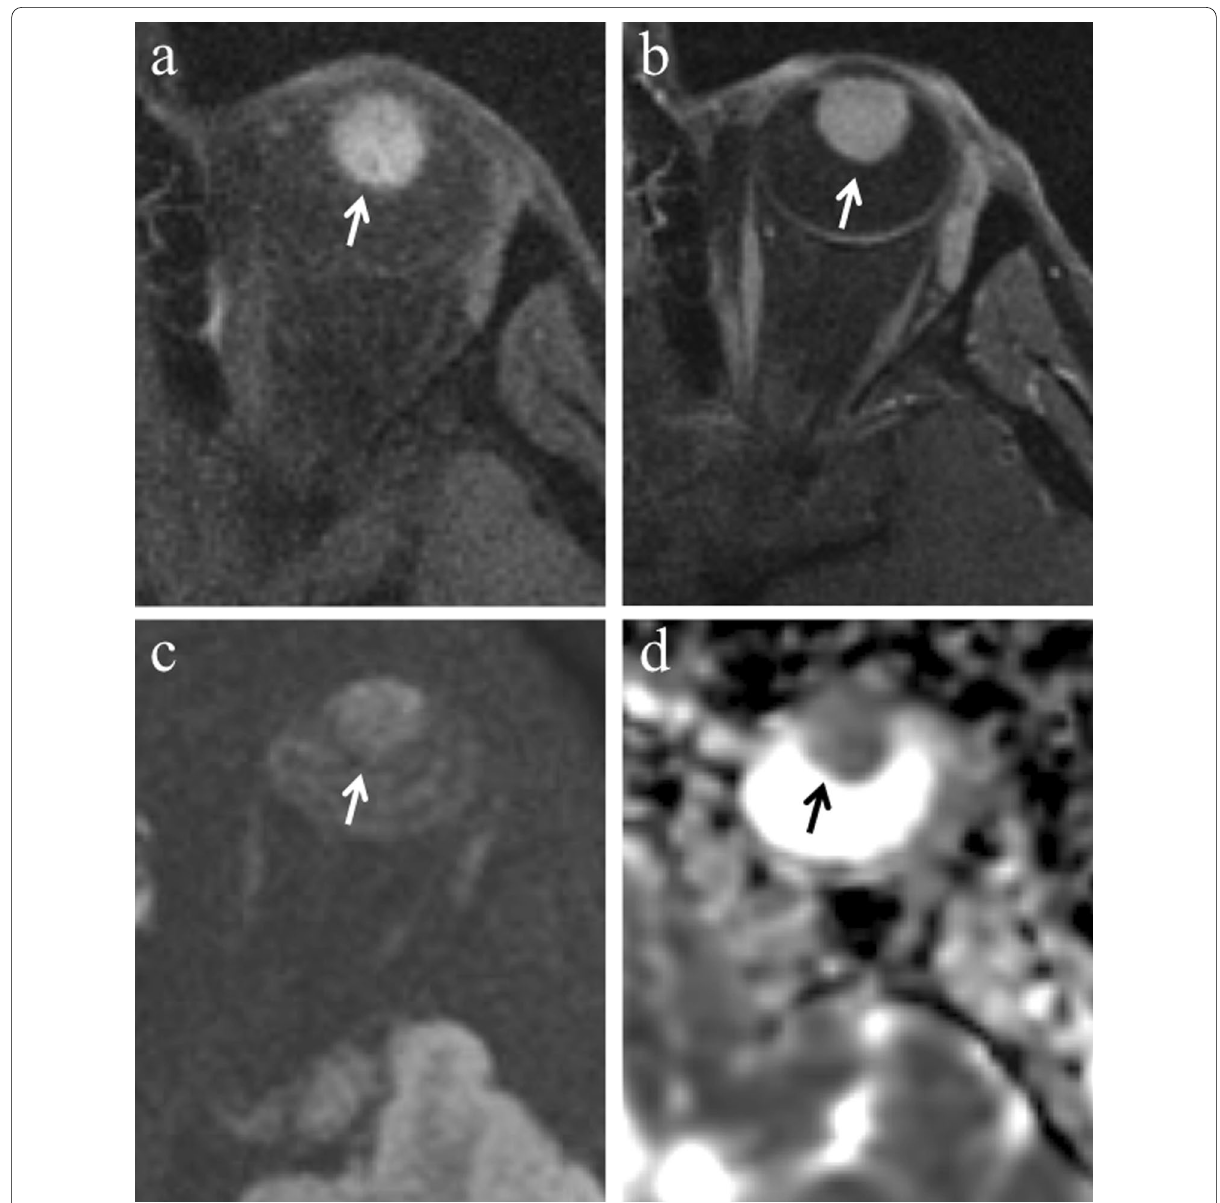
Fig. 13 A 40-year-old man with a pigmented ciliary body melanoma of the left eye. The same patient as in Fig. 1. Axial ( a ) fat-suppressed T1-weighted and ( b ) contrast-enhanced fat-suppressed T1-weighted images illustrate an hyperintense mass along the anterior aspect of the globe (white arrows). After contrast agent administration, the lesion enhancement is hardly detectable due to the intrinsic hyperintensity of the lesion on pre-contrast T1-weighted image. On ( c ) axial DW image (b 1000 s/mm 2 ) and ( d ) corresponding ADC map the lesion exhibits restricted diffusion = with high signal intensity (white arrow) on DWI image and low signal intensity (black arrow) on ADC map, a finding consistent with high